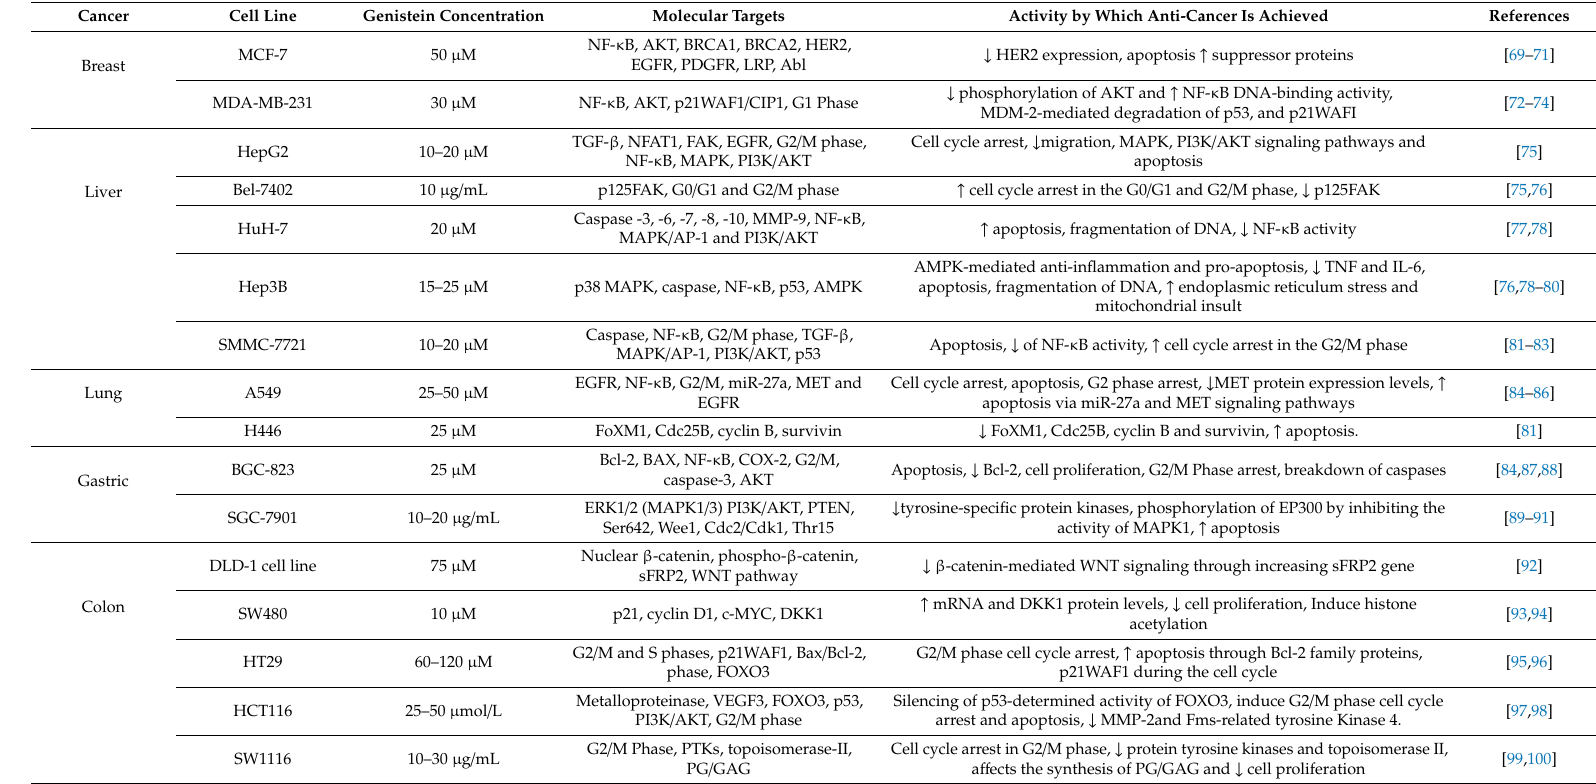
Table 2. Anti-cancer activity and molecular targets modulated by